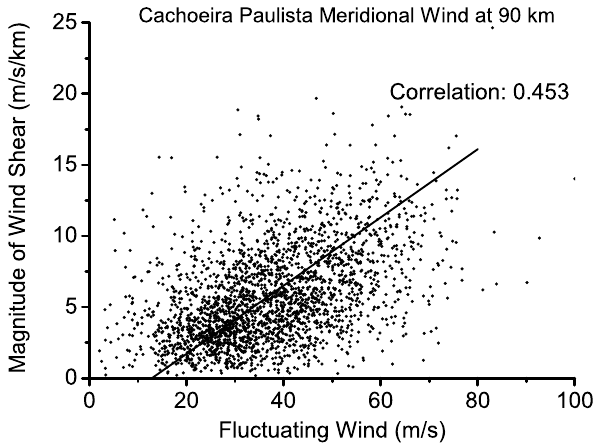
Fig. 8. As for Fig. 7 but wind-shear instead of wind.